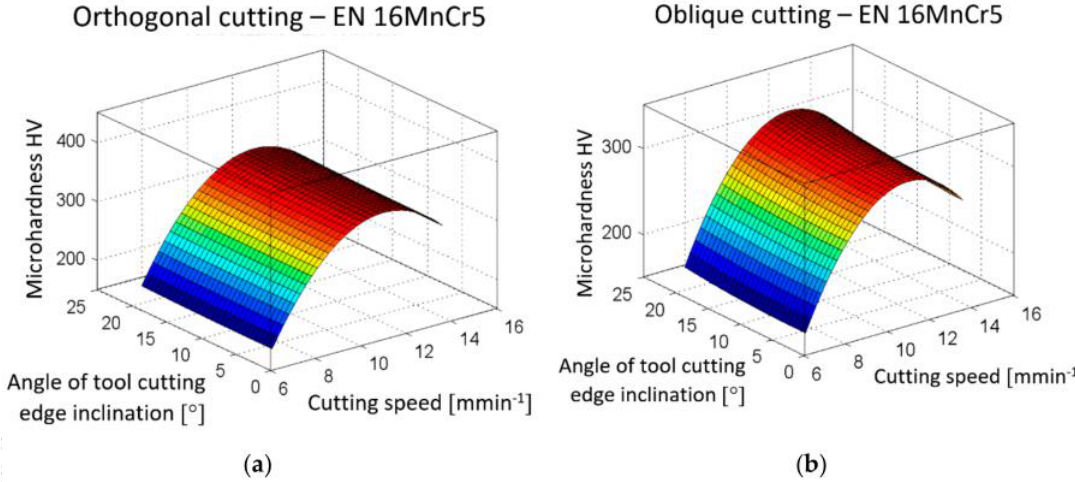
Figure 14. Dependency of microhardness HV on the cutting speed v c and on the angle of tool cutting edge inclination λ s . ( a ) Orthogonal cutting; ( b ) oblique cutting.